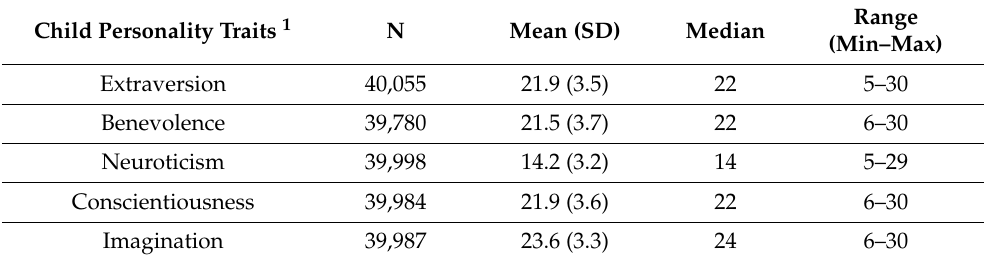
Table 3. Child personality traits 1 . Higher scores indicate higher degree of the specific trait. Child Personality Traits